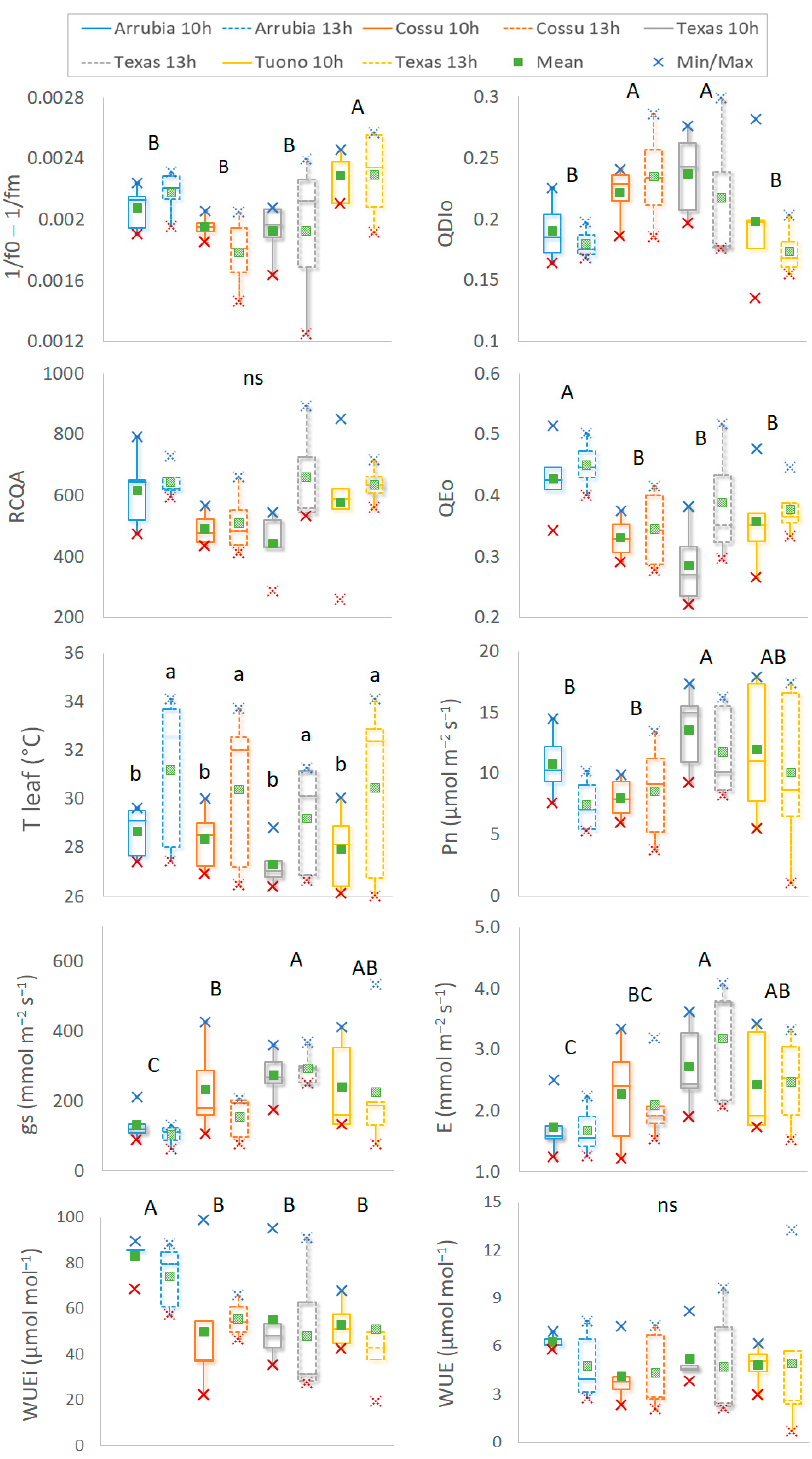
Figure 5. Boxplot and two-way ANOVA significance of the effects of cultivar and daytime measurement for midmorning and midday leaf photochemical and photosynthetic performance during nut growing and ripening stages in the two-year study period. Data are the mean of tree replicates, from 4 dates of measurements (n = 20). Box limits are first and third quartile. Full-line and dotted-line boxplots represent, respectively, data collected during mid-morning and midday. Different capital letters indicate significant differences among cultivar, different lowercase letters indicate significant differences between years and ns indicates not significant differences among